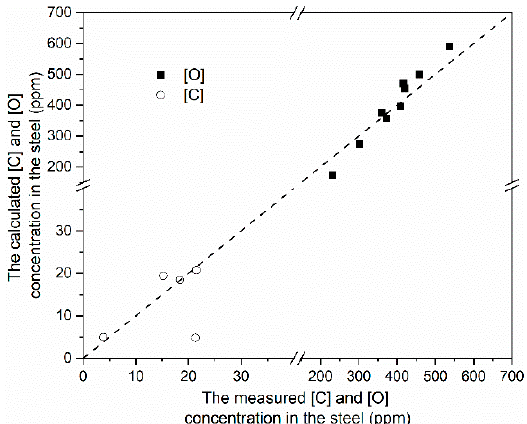
Figure 3. The comparison of the calculated and measured [C] and [O] concentrations during the RH treatment (“[]” indicates dissolved value) [2,9].